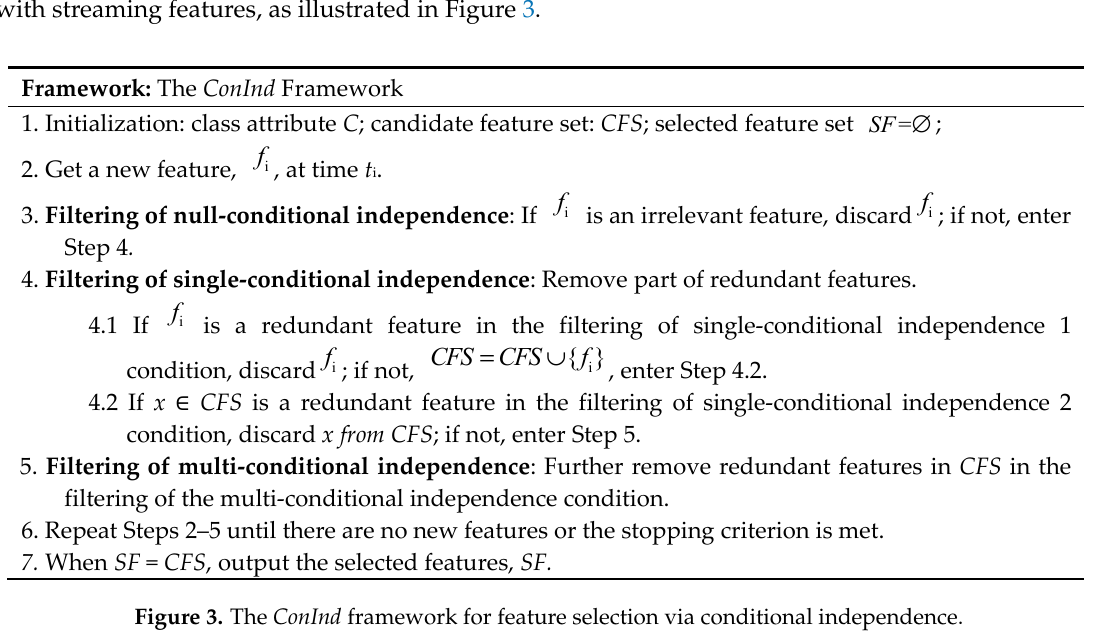
Figure 3. The ConInd framework for feature selection via conditional independence.